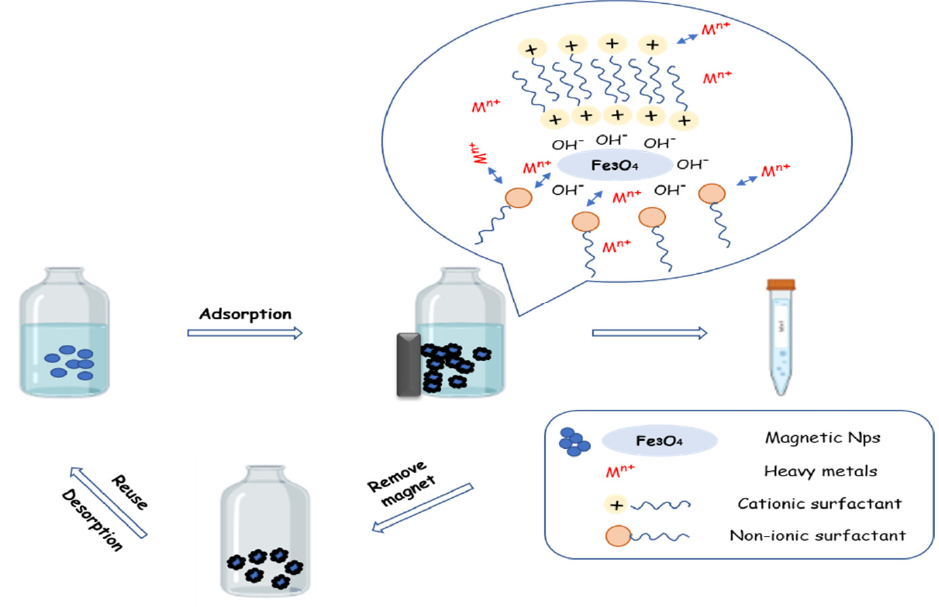
Figure 1. Schematic representation of the water purification cycle.